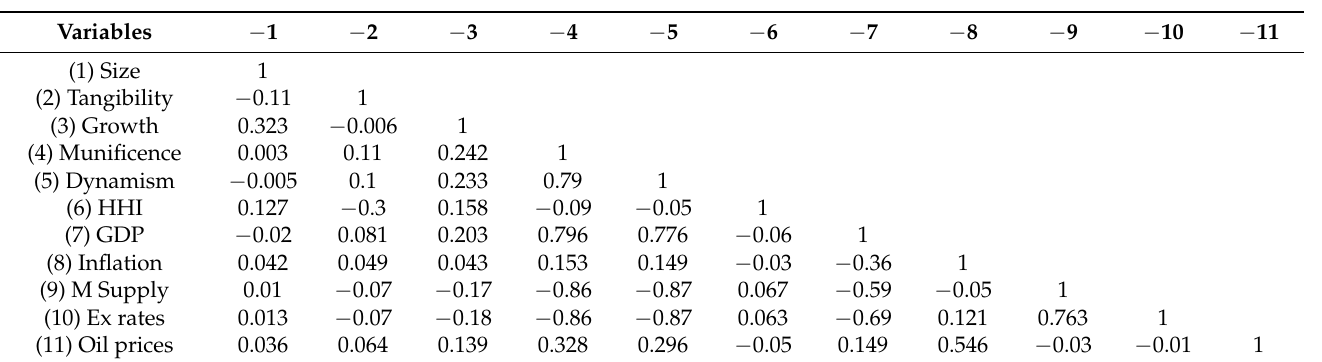
Table A3. Correlation